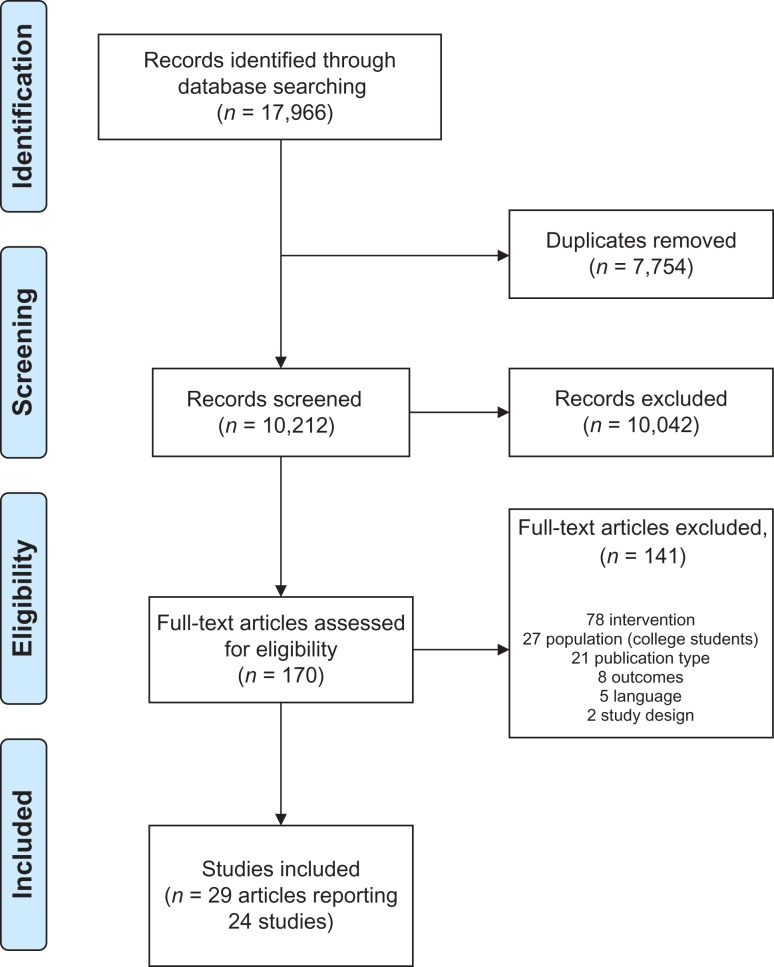
PRISMA flow diagram.